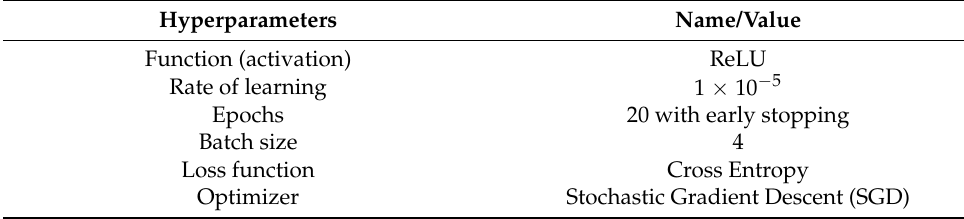
Table 4. Hyperparameters for the Proposed